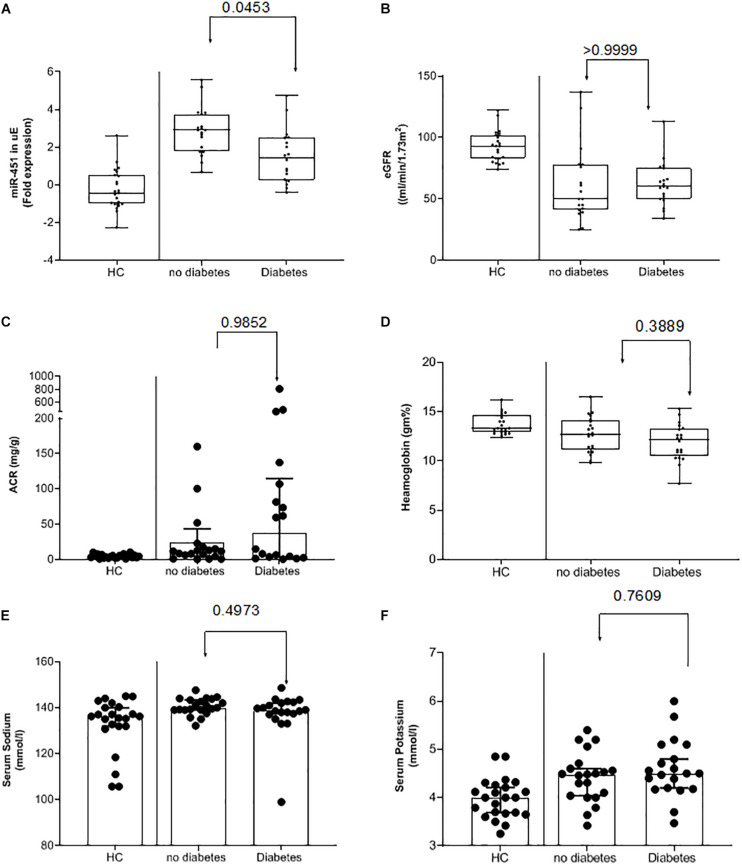
Urinary exosomal miR-451 in kidney disease subjects with or without diabetes. Box and whisker plots and scatter plot of the (A) urinary exosome (uE) miR-451 fold expression relative to 18S ribosomal RNA (normalizing factor) using the formulae 2–ΔCT. Values were log transformed. (B) Estimated glomerular filtration rate (eGFR) and (C) percent hemoglobin (Hb) in healthy control subjects and kidney disease subjects with or without diabetes. Whiskers extend down to smallest value and up to largest value. P-values were calculated by Kruskal–Wallis test. Bar graphs and scatter plot of (D) urine albumin/creatinine ratio (ACR), (E) serum sodium, and (F) serum potassium levels in the three groups. The median fold expression value is represented by the single line within the box with 95% CI. p-values were calculated by one-way ANOVA.